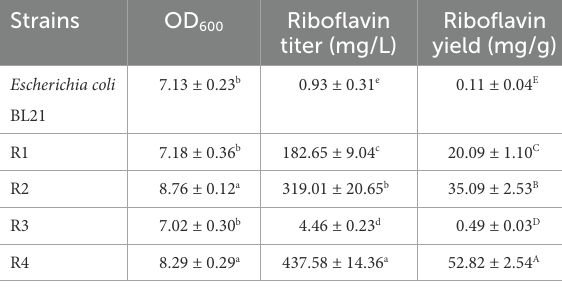
Letters indicate significant differences ( p < 0.05).